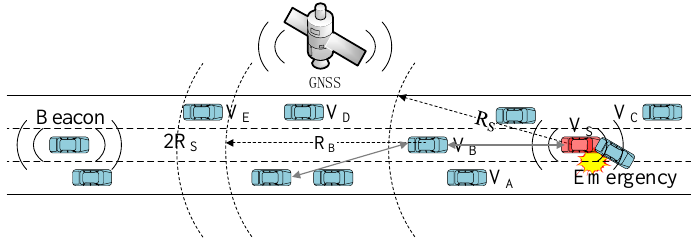
Figure 5. Calculation of the number of two-hop neighbors in the highway scenario.